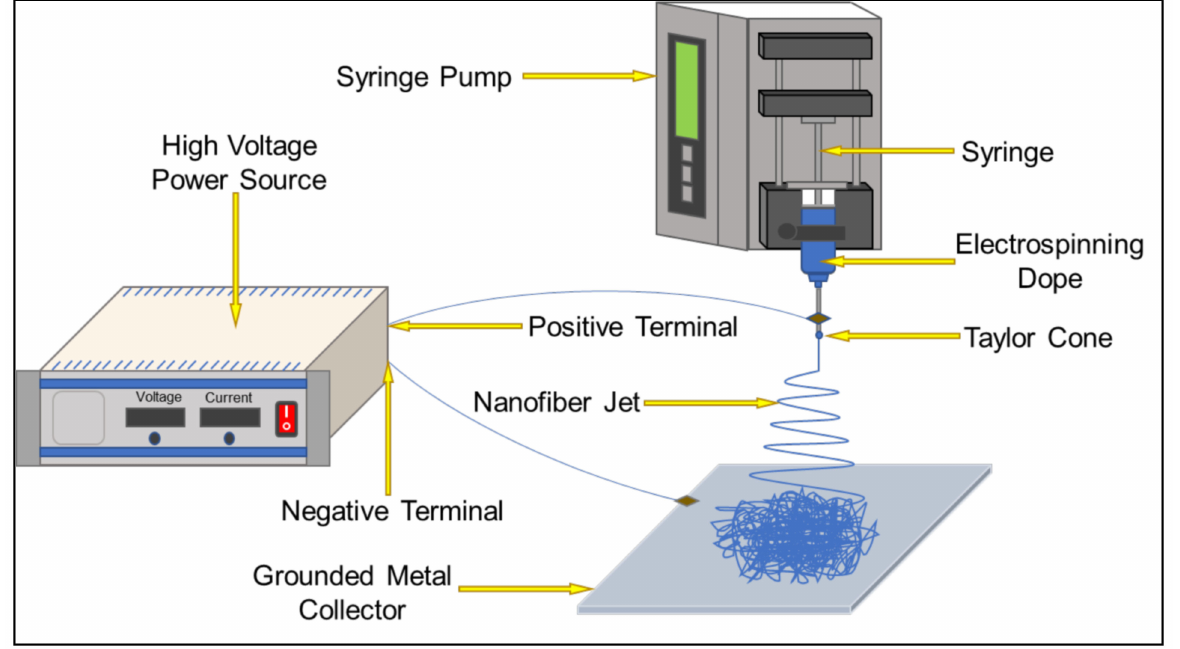
Figure 4. Schematic diagram of the electrospinning